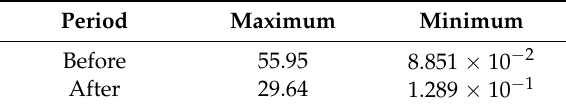
Table 1. Comparison of stress distribution before/after optimization.